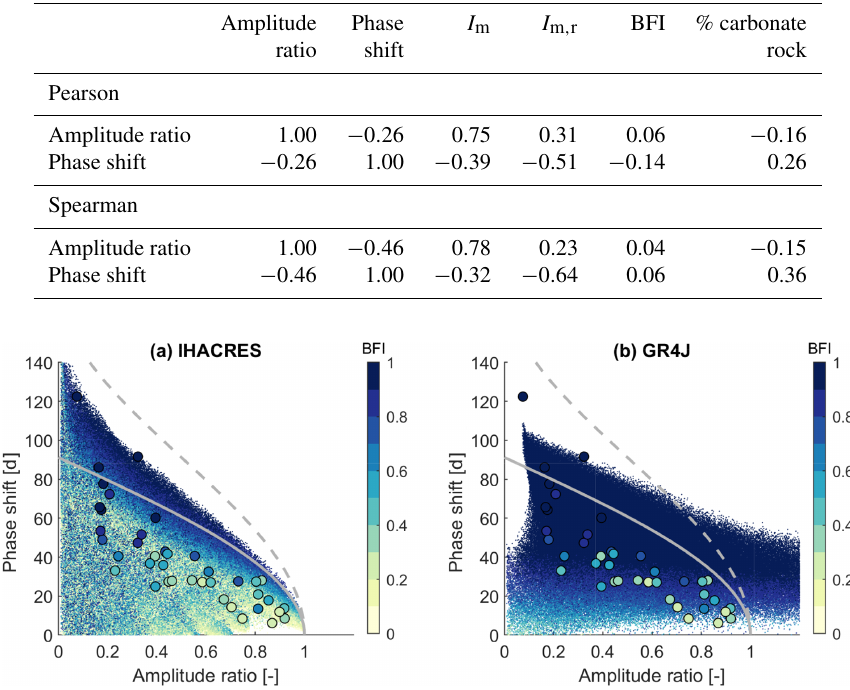
Table 3. Pearson and Spearman correlation coefficients between seasonal signatures and catchment attributes for CAMELS catchments.